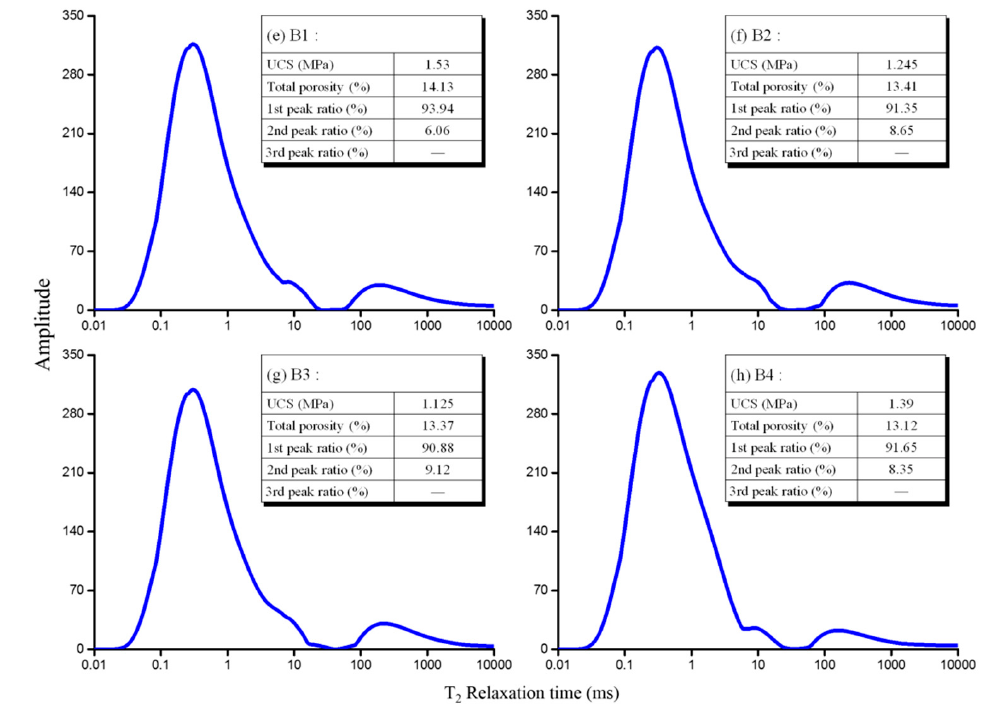
Figure 5. Pore size distribution of group B.